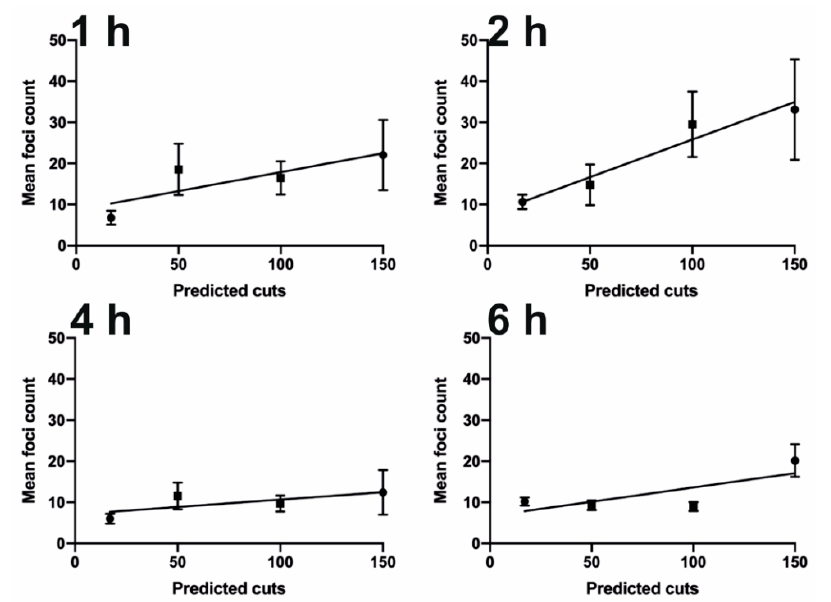
Figure 5. Correlation between the predicted number of cuts and detected γ H2AX foci. The mean is as shown in Figure 3. The time refers to hours post-electroporation. The bars represent the 95% confidence interval (CI).